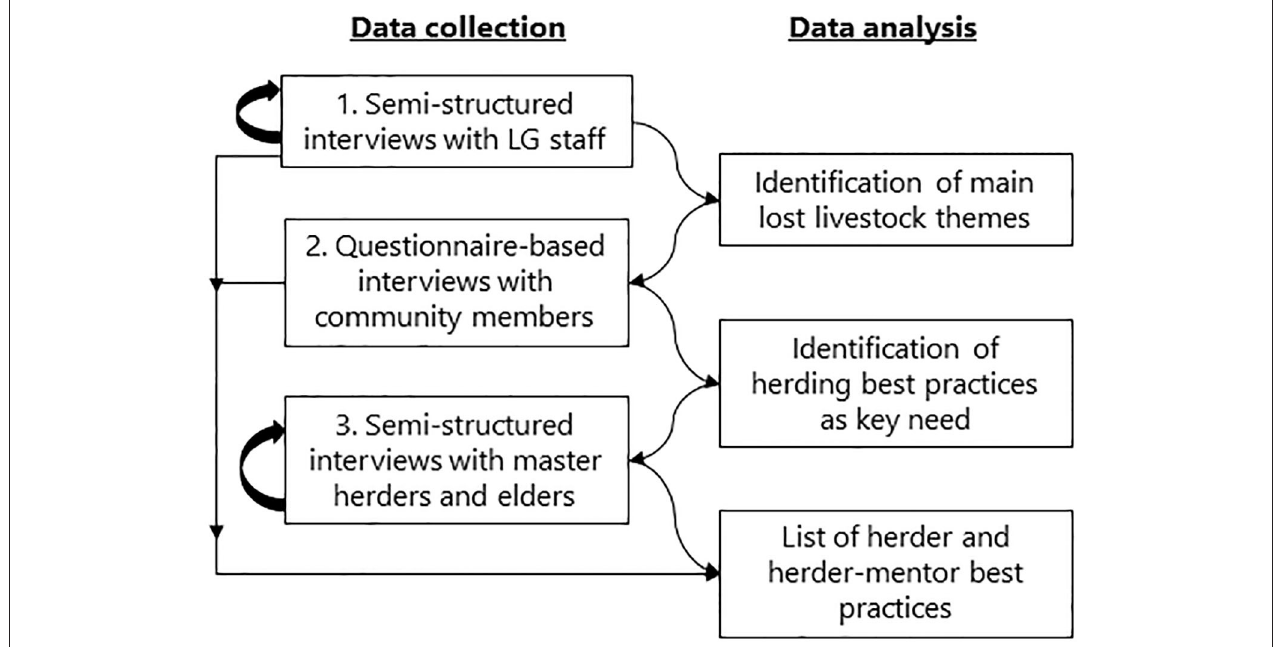
FIGURE 2 | The iterative data collection and analysis process, wherein each stage built upon what came before. Stages 1 and 3 were internally iterative, such that the conversation evolved as we proceeded. The data analysis column shows the key finding from each stage but is not comprehensive. All data collection stages informed the generation of herder and herder-mentor best practice